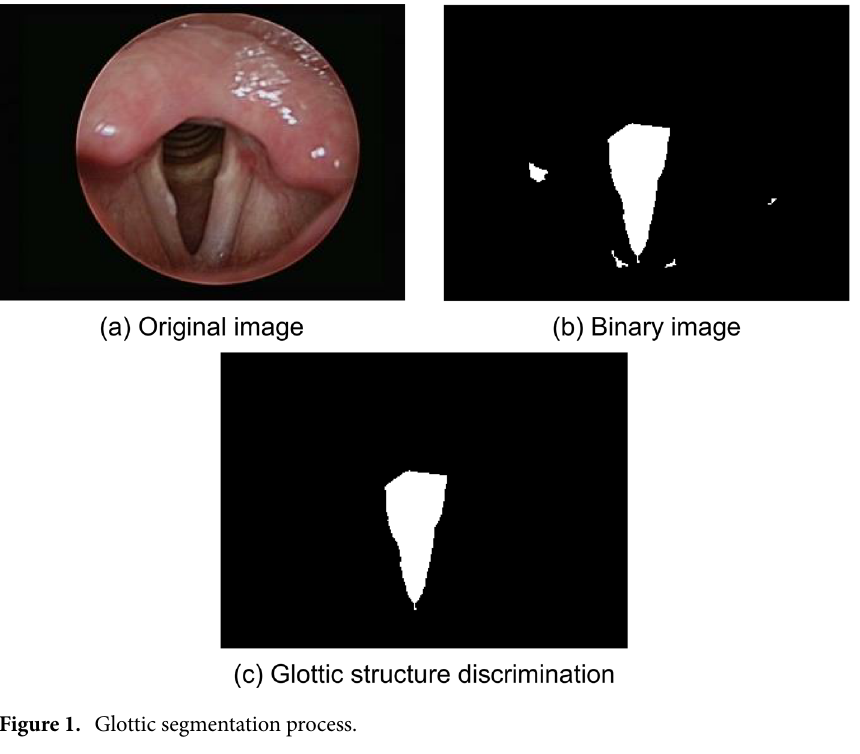
Figure 1. Glottic segmentation process.